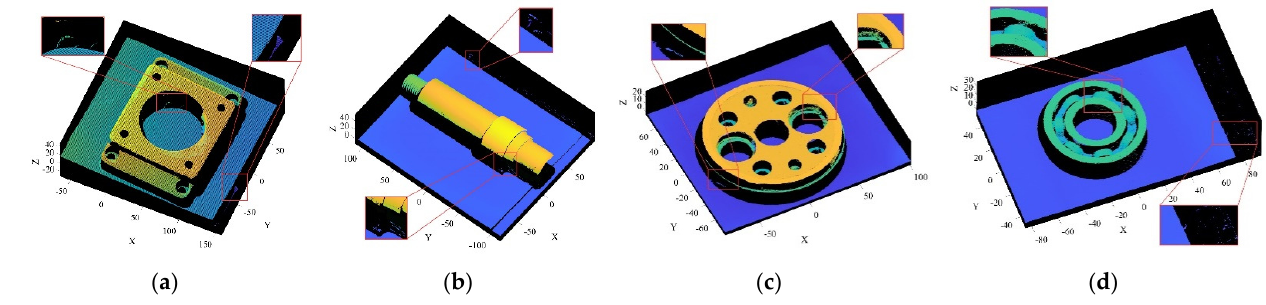
( d ) Figure 12. Denoising results for NLD algorithm: ( a ) object 1; ( b ) object 2; ( c ) object 3; ( d ) object 4.